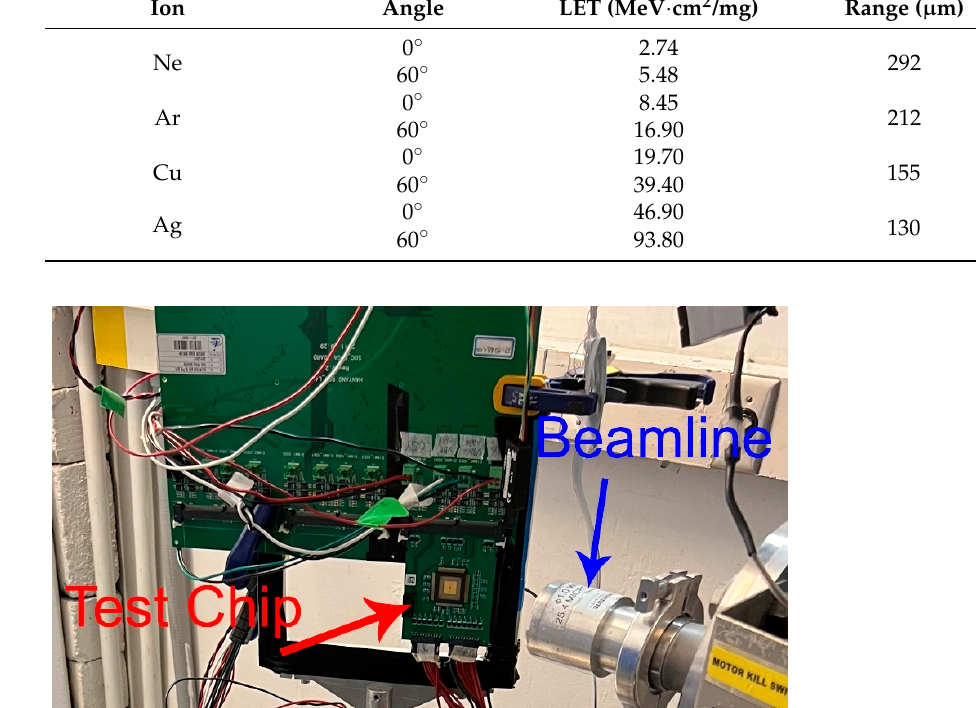
( b ) Figure 9. Cross − sectional values for heavy ion testing at a 0° incidence angle from normal, ( a ) core voltage of 0.8 V, ( b ) core voltage of 0.6 V.